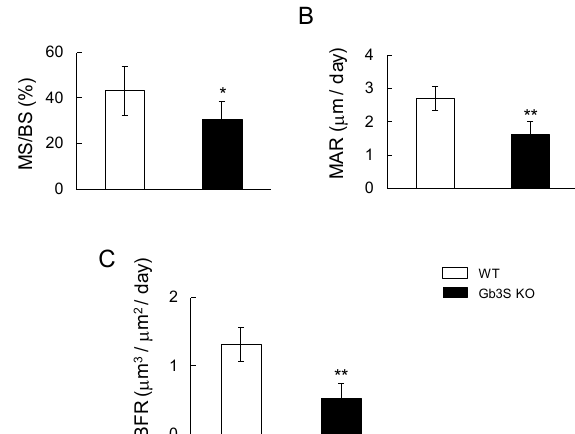
Figure 5. Attenuation of bone formation by Gb3 synthase deficiency in 15-week-old mice (male, n = 6 for WT, n = 6 for Gb3S KO). ( A ) Mineral surface / bone surface (MS / BS, %). ( B ) Mineral apposition rates (MAR, µ m / day). ( C ) Bone formation rate (BFR, µ m 3 / µ m 2 / day). Data are expressed as mean ± S.D. The single and double asterisks indicate p < 0.05 and p < 0.01, respectively.